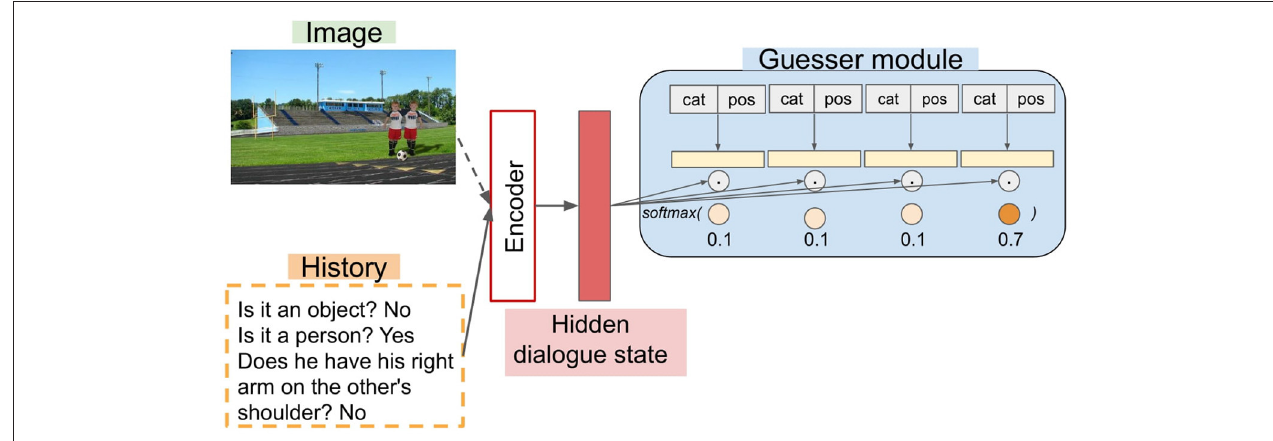
FIGURE 3 | Shared Encoder-Guesser skeleton. The Guesser receives the category labels (e.g., “bottle”) and the spatial coordinates (pos) of each candidate object. Multimodal encoders receive both the image and the dialogue history, whereas blind models receive only the